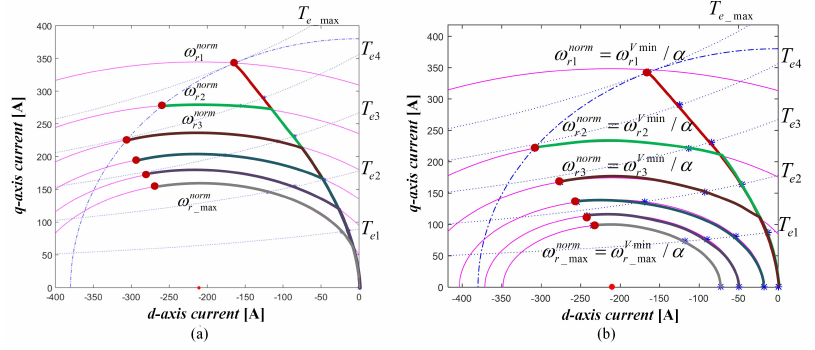
Figure 4. Speed-torque 2D-LUT established using 6X6 memory map ( a ) Speed-torque 2D-LUT established under V norm ( b ) Proposed speed-torque 2D-LUT